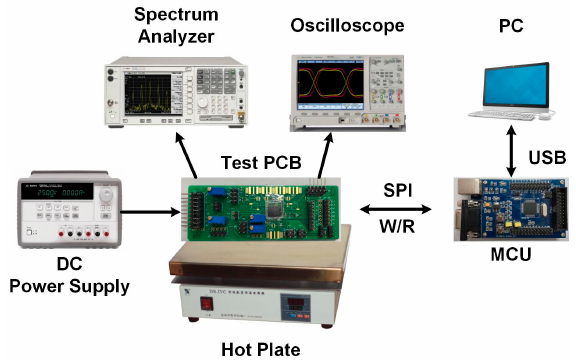
Figure 18. Measurement set-up. The proposed chip and the SAW device are on the test PCB, and the test PCB is controlled by a MCU board which is further connected to PC for data collection.